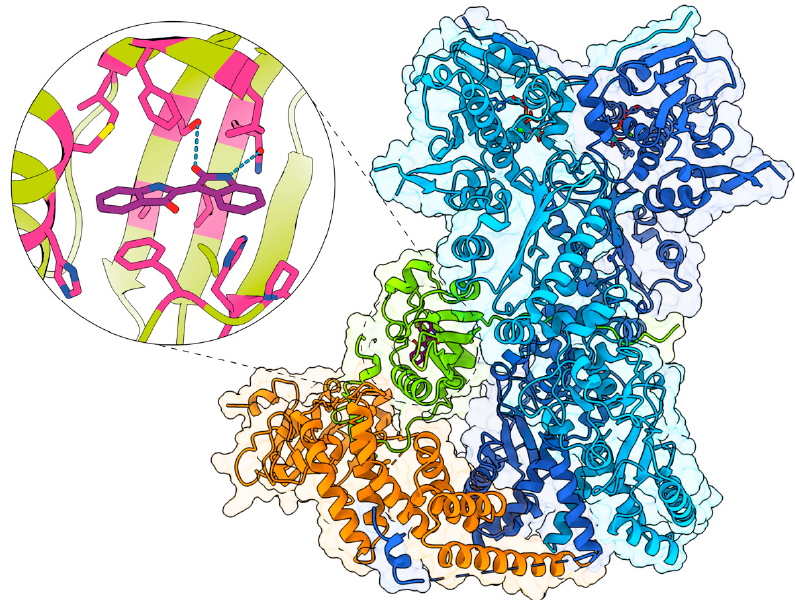
Figure 1. The atomic model of the AHR complex in cartoon representation: HSPA ( light blue ), HSPB ( dark blue ), XAP2 ( orange ), and AHR ( green , representing amino acid residues 1–437). The insert highlights the ligand ‐ binding pocket with indirubin.